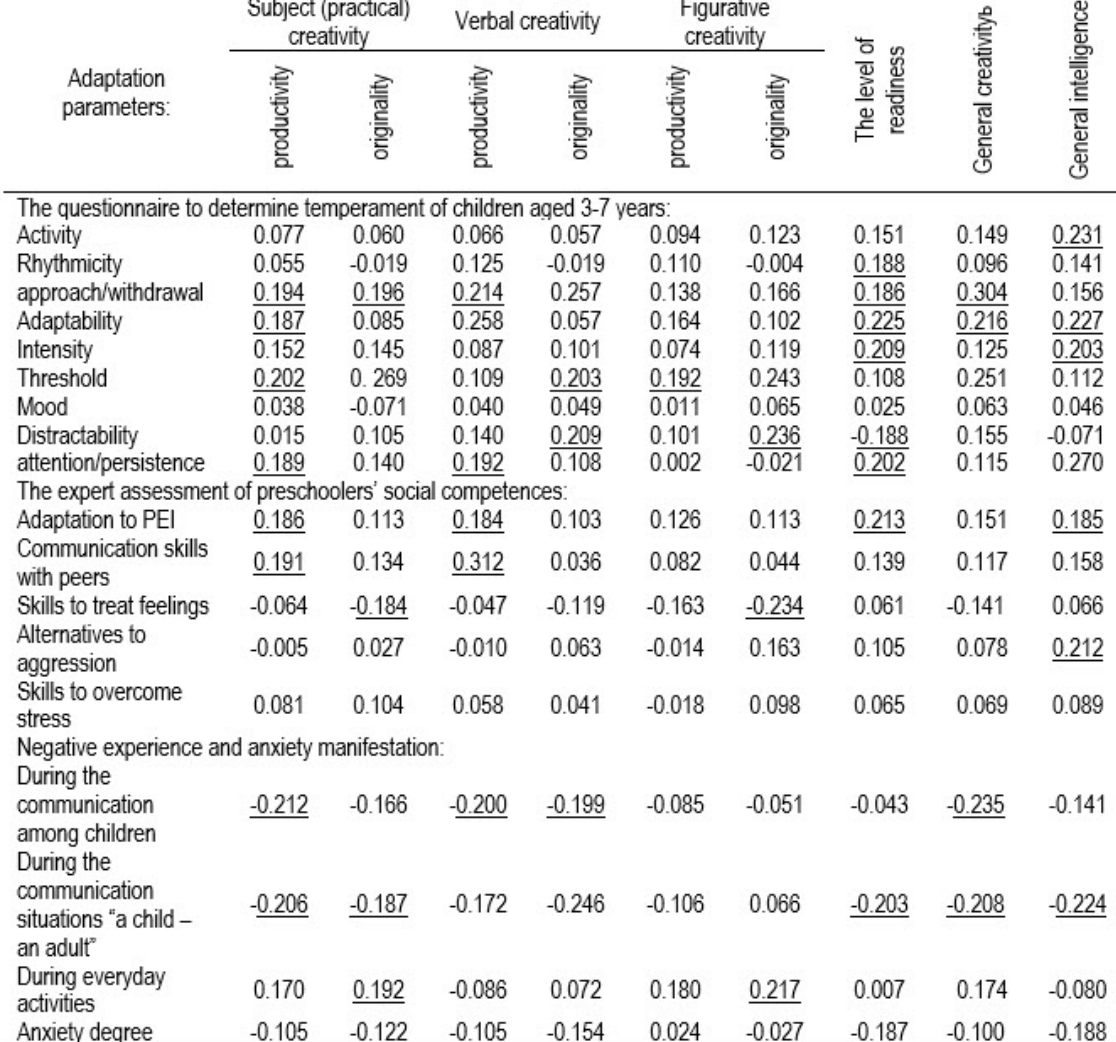
Correlations of indicators for cognitive abilities and adaptation measures in a sample of 115